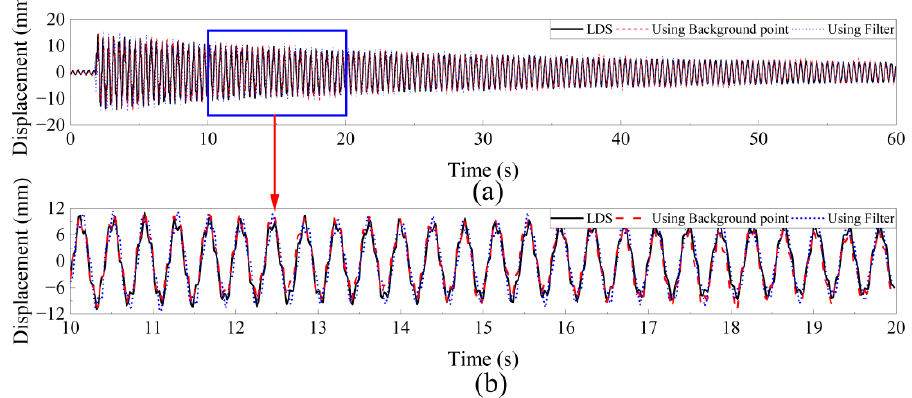
Figure 9. Time-domain comparison of UAV monitoring time history denoising processing: ( a ) full displacement monitoring; ( b ) 10~12 s displacement monitoring.